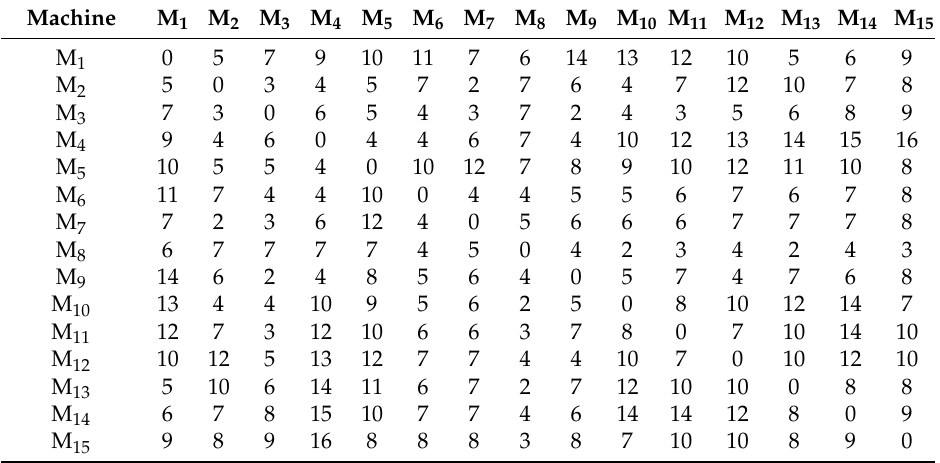
Table 4. The transportation time of a product between di ff erent machines.